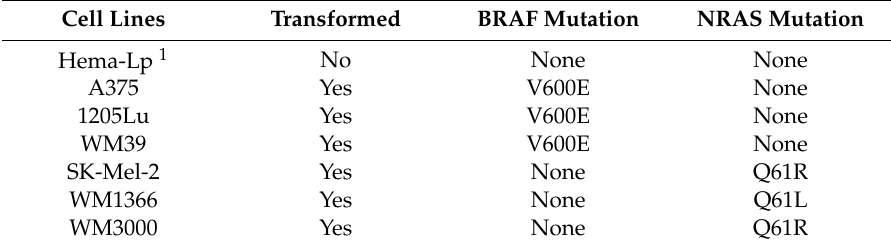
Table 1. Characteristics of melanoma and melanocyte cell lines.